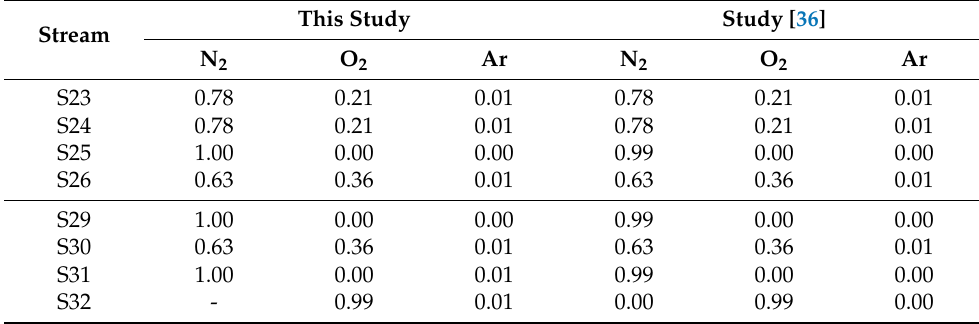
Table A11. Model verification: molar stream composition—HPC and LPC column.